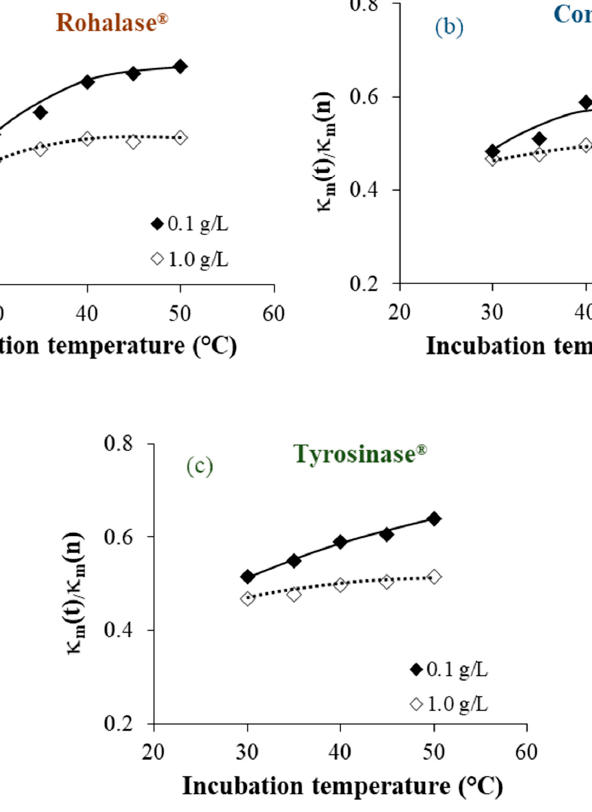
Figure 1. Dependence of κ m (t) for the treated CMX-Sb on incubation temperatures and concentrations of Rohalase ® ( a ); Corolase ® ( b ), and Tyrosinase ® ( c ).